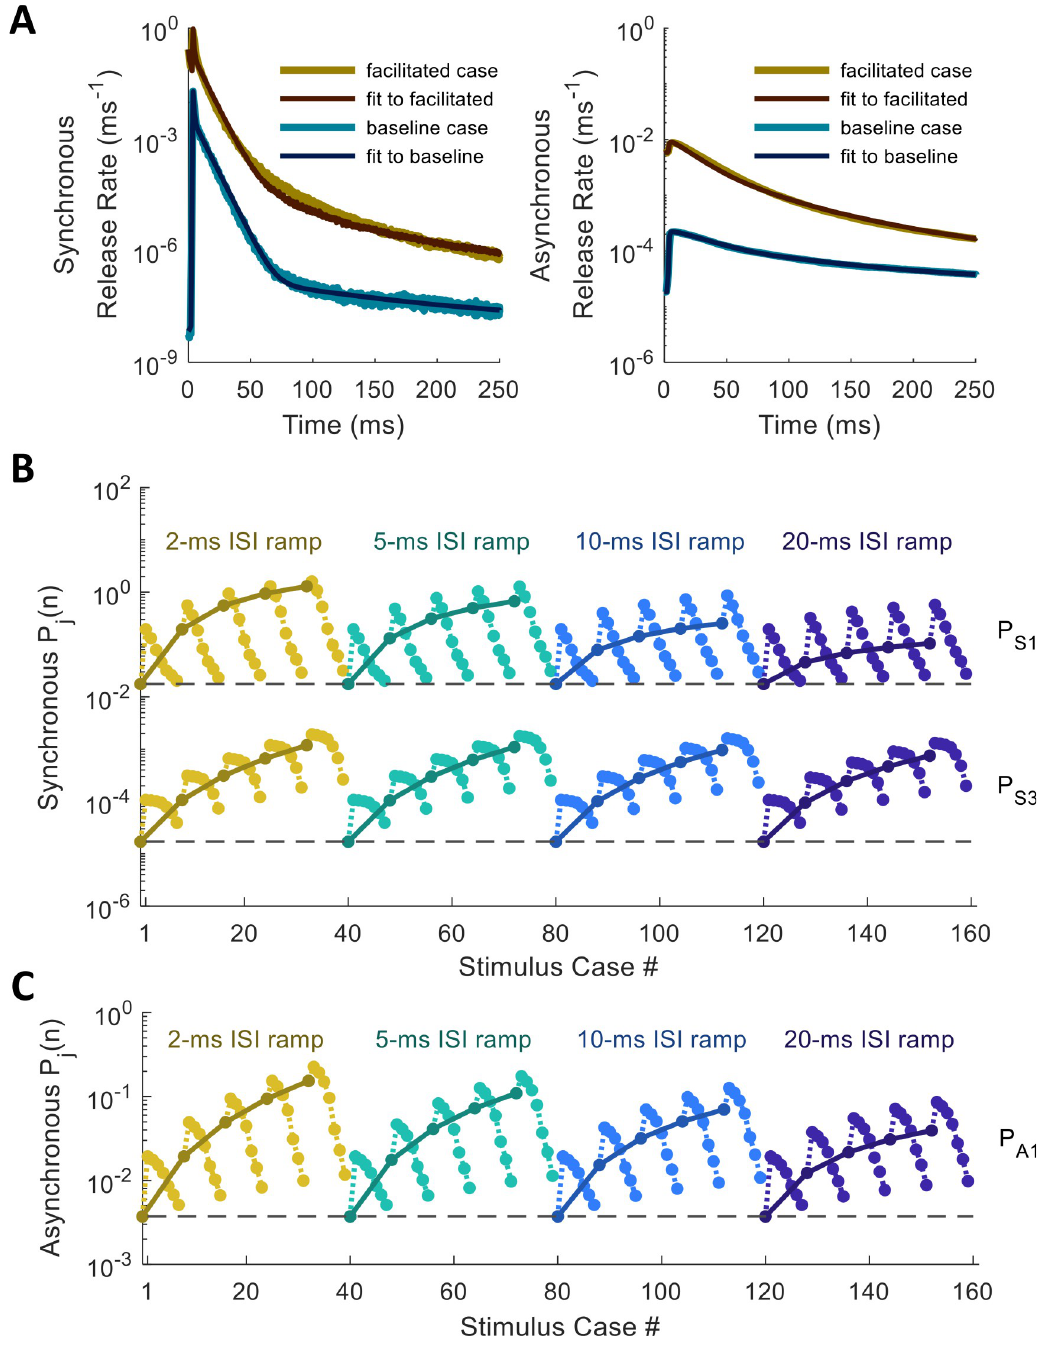
Fig 10. Release Rate Parameters and Facilitation Metaparameters Fitted to Empirical Histogram Profiles. (A) Synchronous and asynchronous profiles fitted for baseline (un-facilitated) case, and for highly facilitated case (probe spike 5 ms after 5-spike ramp of 5-ms ISIs). (B,C) Release fidelity values fitted case-by-case (dark colors) overlaid with predictions from best-fit facilitation functions (light colors) for synchronous (B) and asynchronous (C) components.